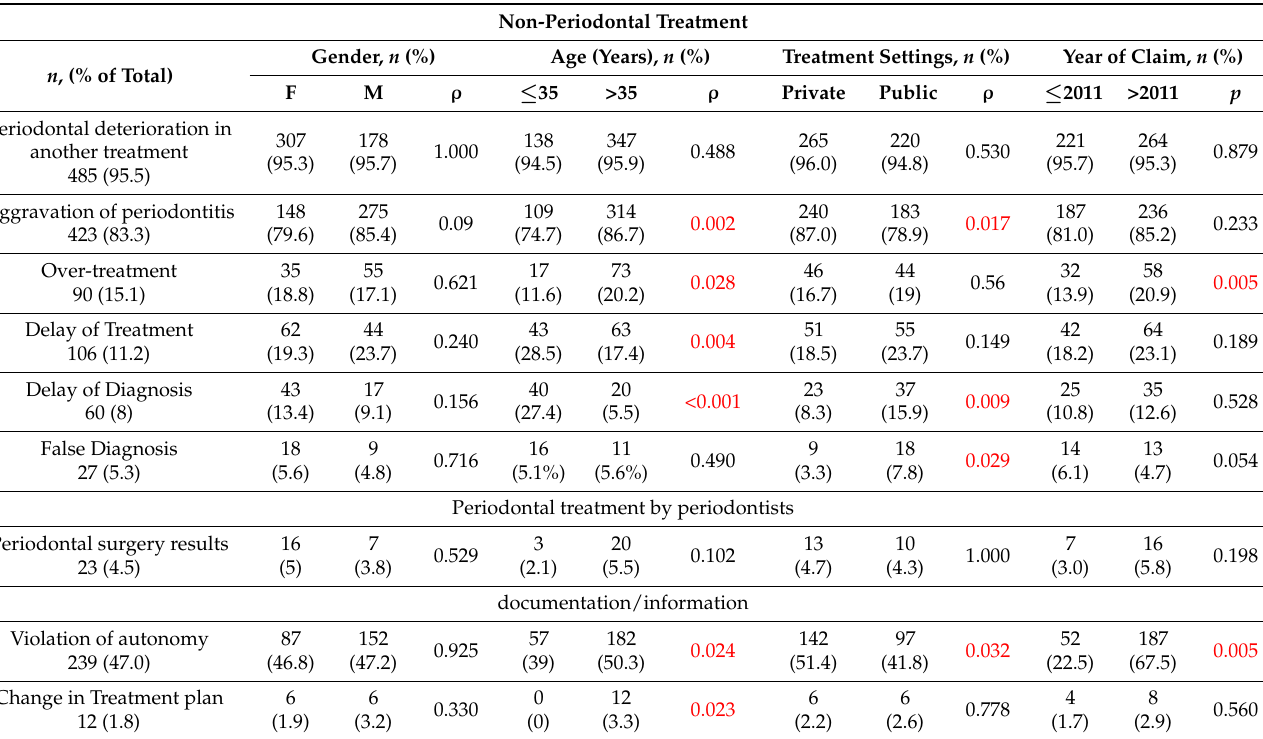
Table 2. Allegation nature by general